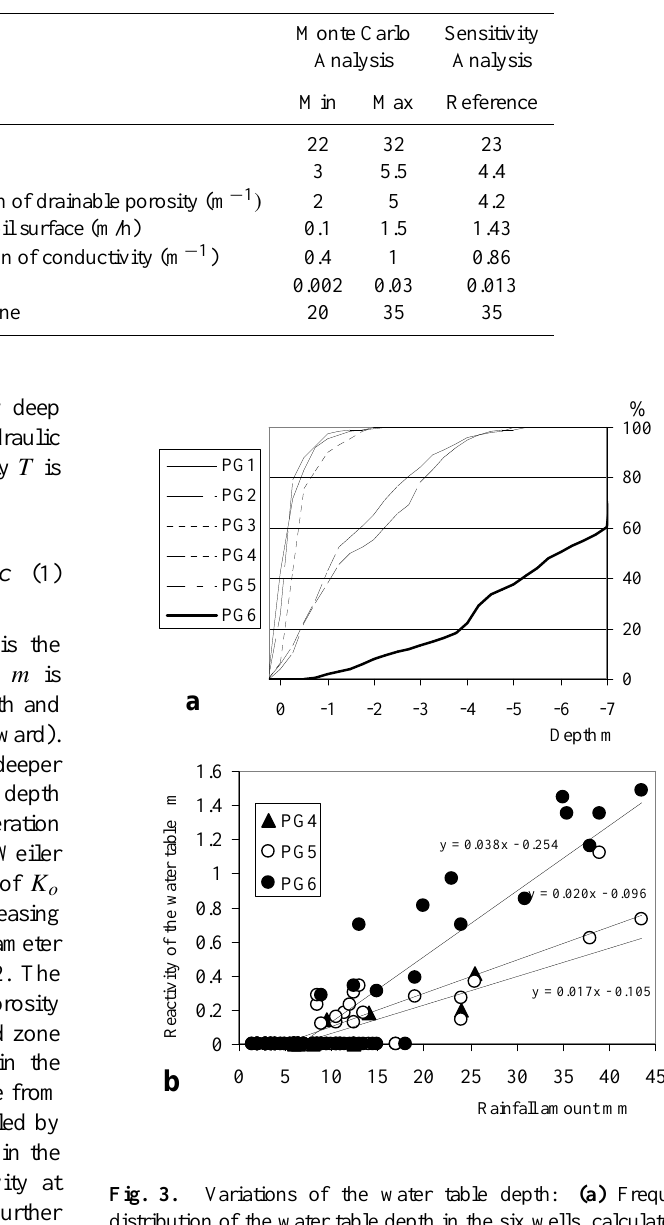
where x is the distance to the stream and Var o can be the hydraulic conductivity, the drainable porosity or the parameter that determines the exponential decline in hydraulic conductivity with depth ( m